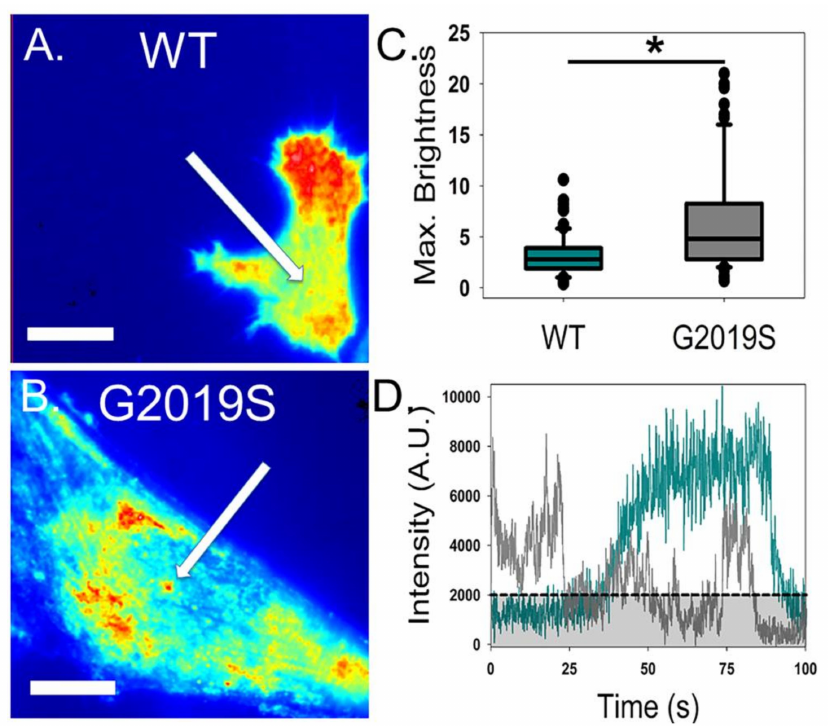
Figure 3. G2019S LRRK2-GFP has altered distribution and time dependence near the plasma membrane. Average total internal reflection fluorescence (TIRF) microscopy intensity images for WT LRRK2-GFP ( A ) and G2019S LRRK2-GFP ( B ), with arrows depicting clustering of fluorescent molecules. Color within this figure represents the level of intensity detected by the CCD, which is scaled proportionally from lowest (blue) to the maximum intensity (red). ( C ) Comparison of the largest detected fluorescent component near the plasma membrane of WT and G2019S-expressing cells ( p < 0.05). ( D ) Representative fluctuation of fluorescence intensity at a puncta during a 100 s time period for WT (dark cyan) and G2019S (gray). The black line represents minimal intensity change for inclusion of a fluctuation event. Scale bars are 12 µ m. n ≥ 40 cells per